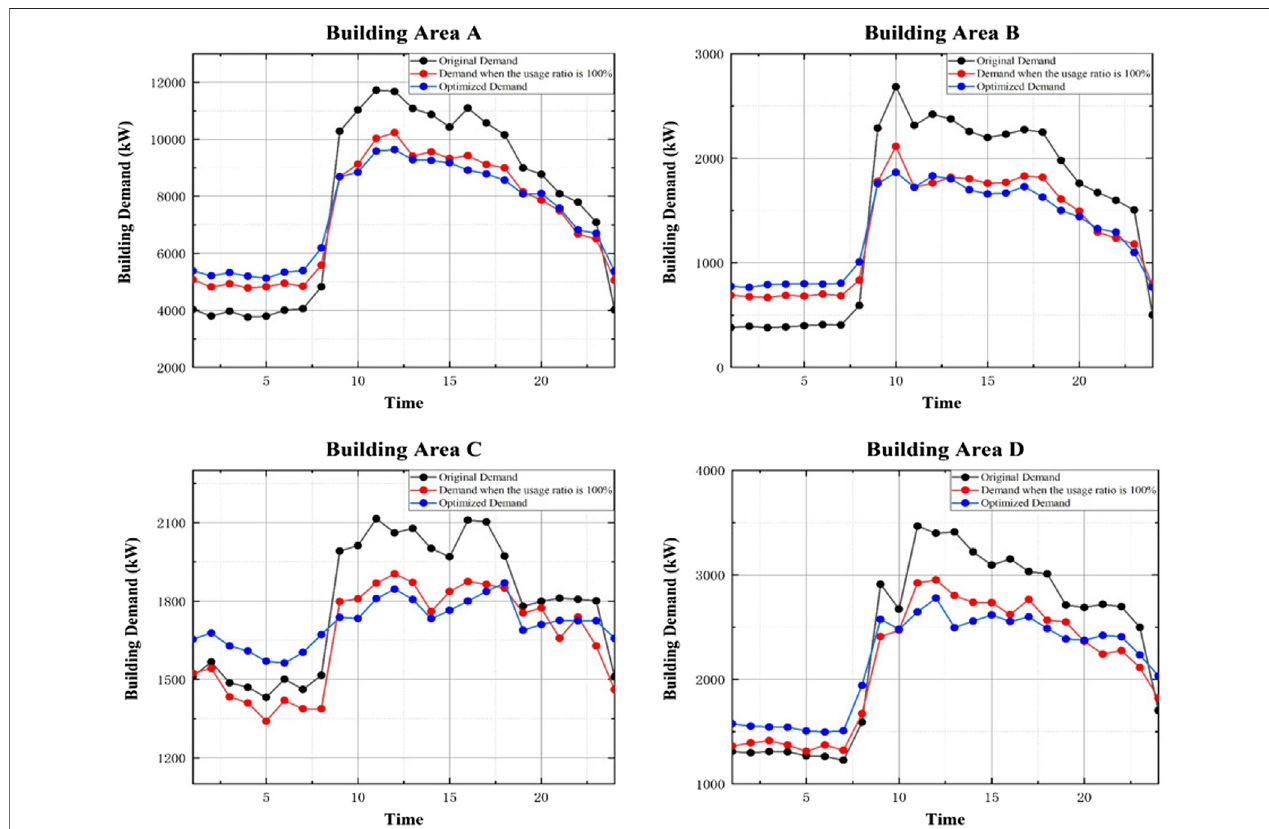
FIGURE 9 | Optimized demand pro fi les of four campus accounts on the test day of generation and storage buildings.